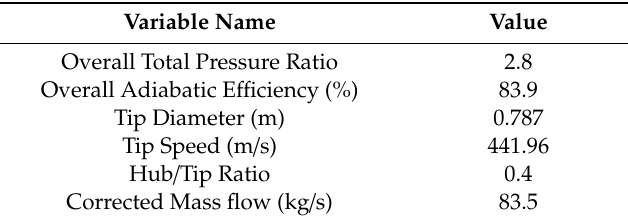
Table 1. Main design parameters of the compressor.